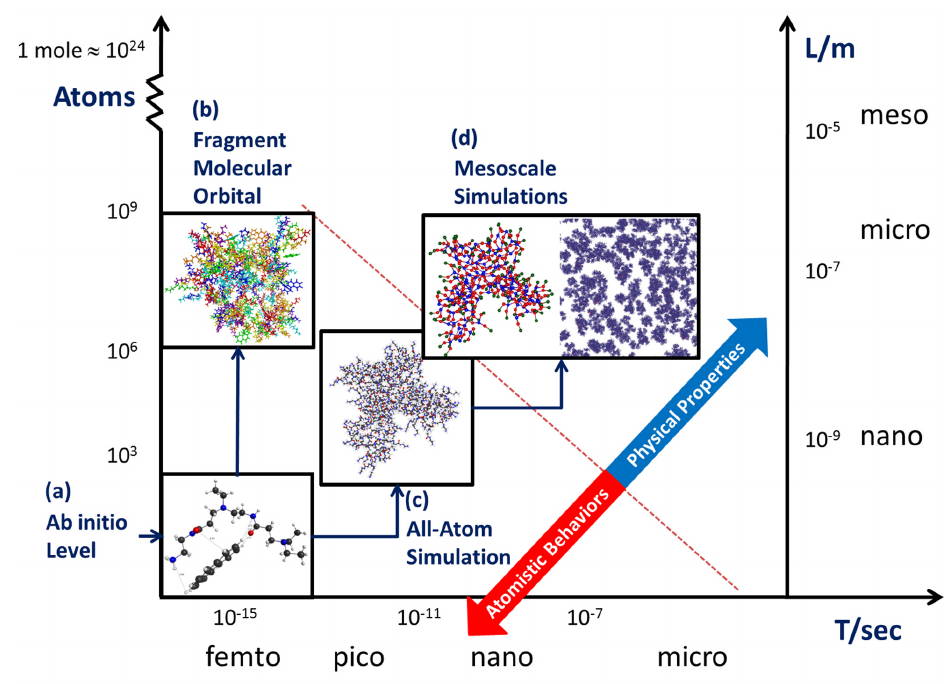
Figure 1. Illustration of the temporal and spatial scales in the complex system of polyamidoamine dendrimers (PAMAM) and phenanthrenes (Phe). There are four systems included in this figure: ( a ) PAMAM branch and Phe molecule (ab-initio); ( b ) fragments of G5 PAMAM dendrimer with 4 Phe molecules by a rainbow color notation (FMO); ( c ) G5 PAMAM dendrimer (All-atom simulation); ( d ) coarse-graining G5 PAMAM and 216 coarse-grained G5 PAMAM dendrimers with 216 Phe molecules (Mesoscale